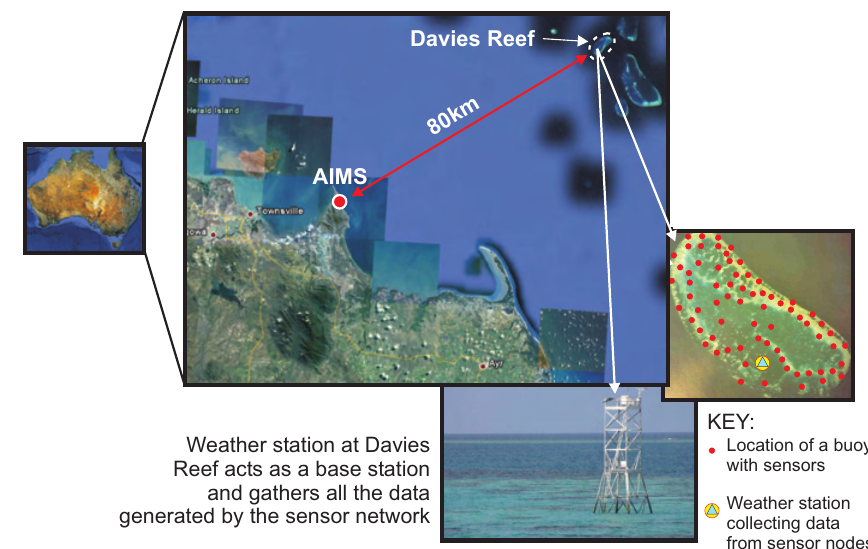
Figure 3. Data collected by the sensor network is transmitted to AIMS via a microwave link (Adapted from